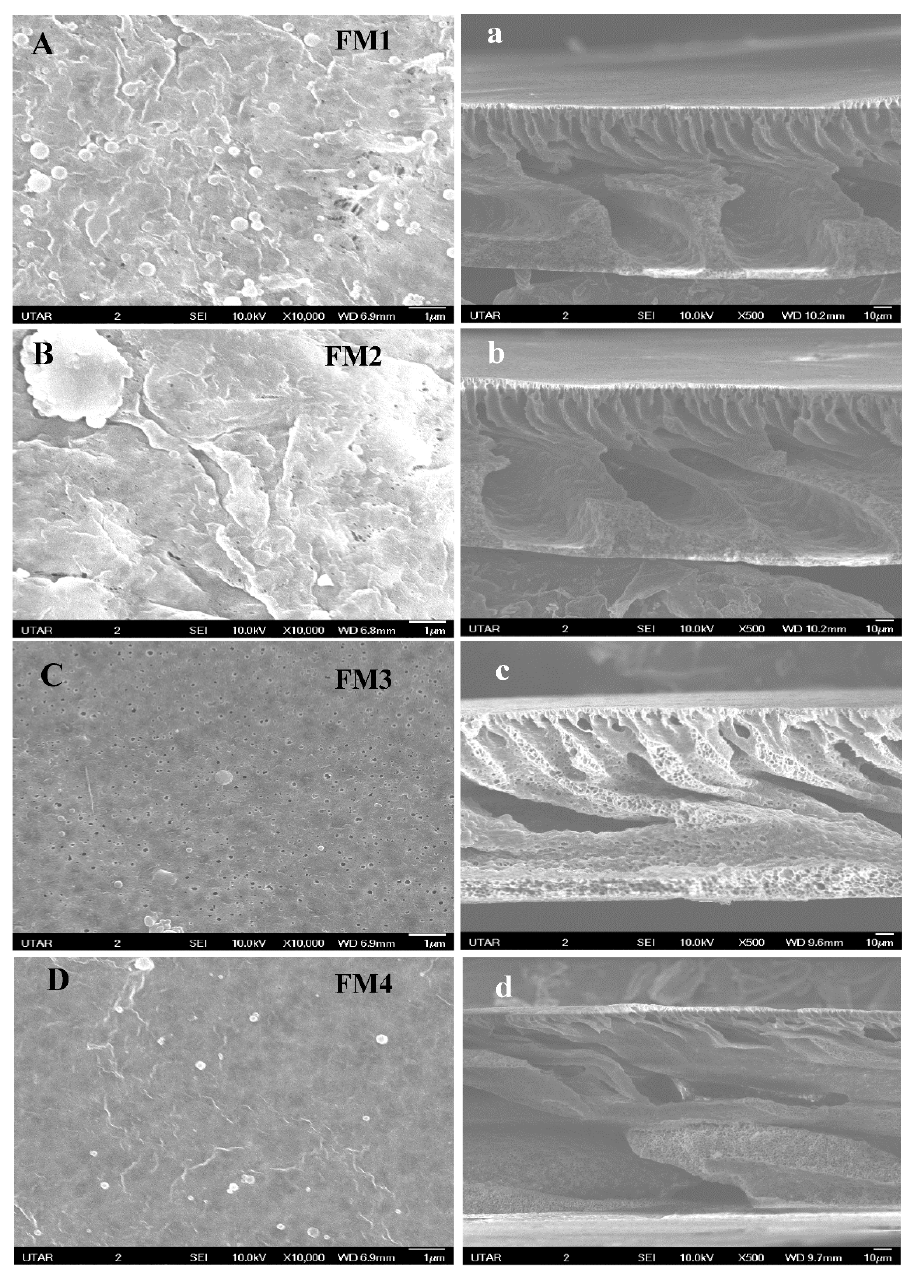
Figure 10. FESEM morphologies of PVDF-PAC membranes with different compositions (FM1 to FM4): ( a – d ) cross-sections and ( A – D ) top surfaces.